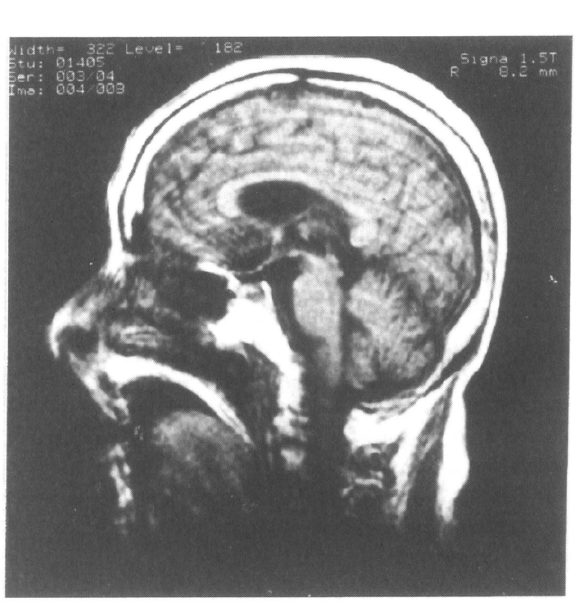
FIG. 2. MRI scan showing marked brainstem